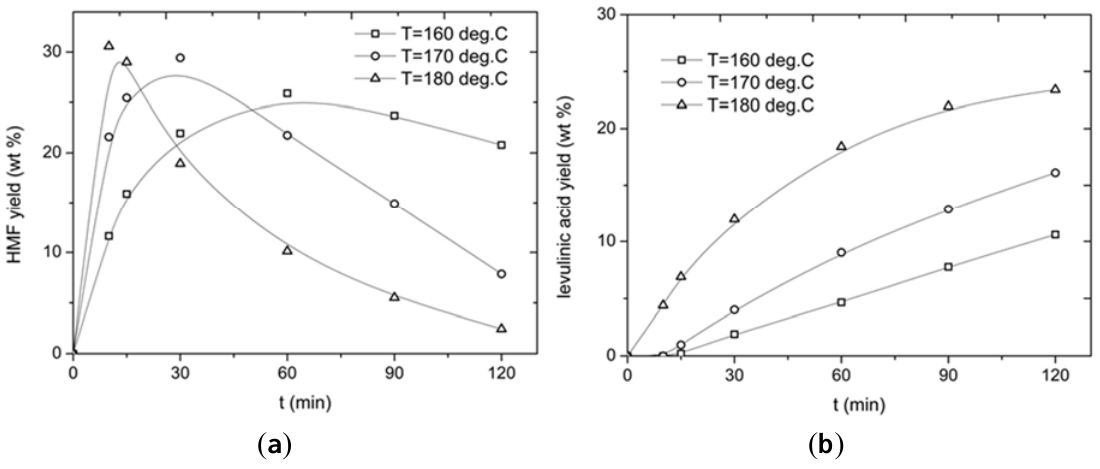
Figure 7. Yield of ( a ) HMF and ( b ) LA versus time at different temperatures = 0.01 ( C inulin = 0.1 g/mL, C CuCl 2